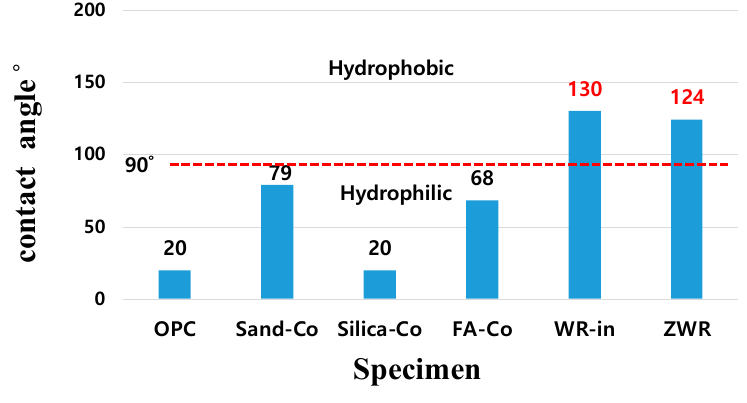
Figure 8. Result of contact angle test.